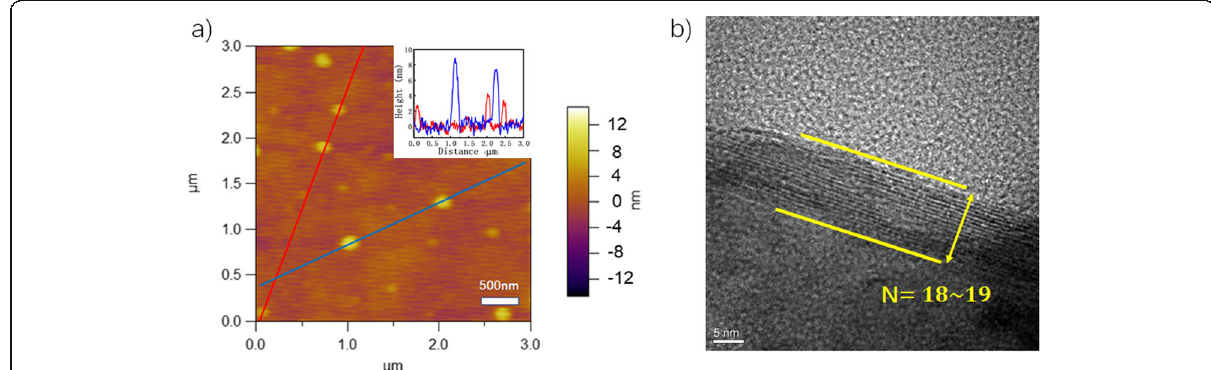
Fig. 4 a AFM topography of exfoliated MoS 2 nanosheets and the cross-sectional height profiles obtained from line scanning in a (inset). b HRTEM images showing the exposed edge of an exfoliated